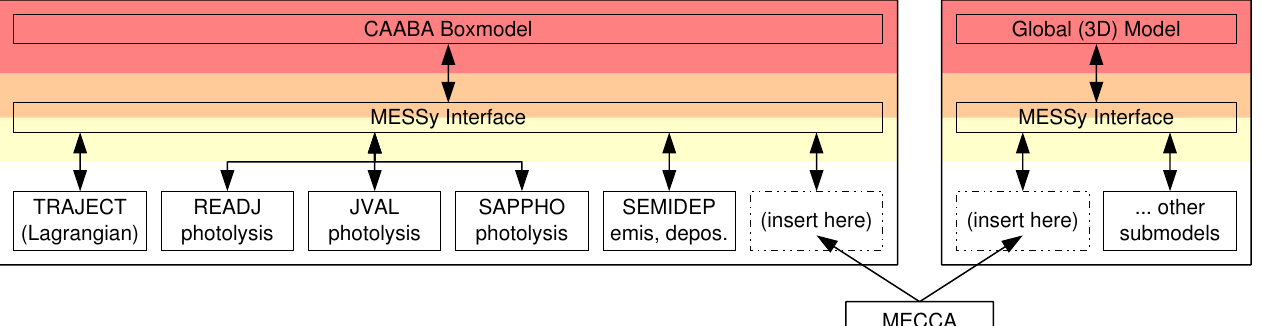
Fig. 1. Left: the modular structure of the CAABA box model and its submodels, which are connected via the MESSy interface. Right: Illustration showing that the MECCA chemistry submodel can also be plugged into a global, 3-dimensional model, e.g., a general circulation model (GCM). Likewise, the photolysis submodel JVAL can also be plugged into a global model.